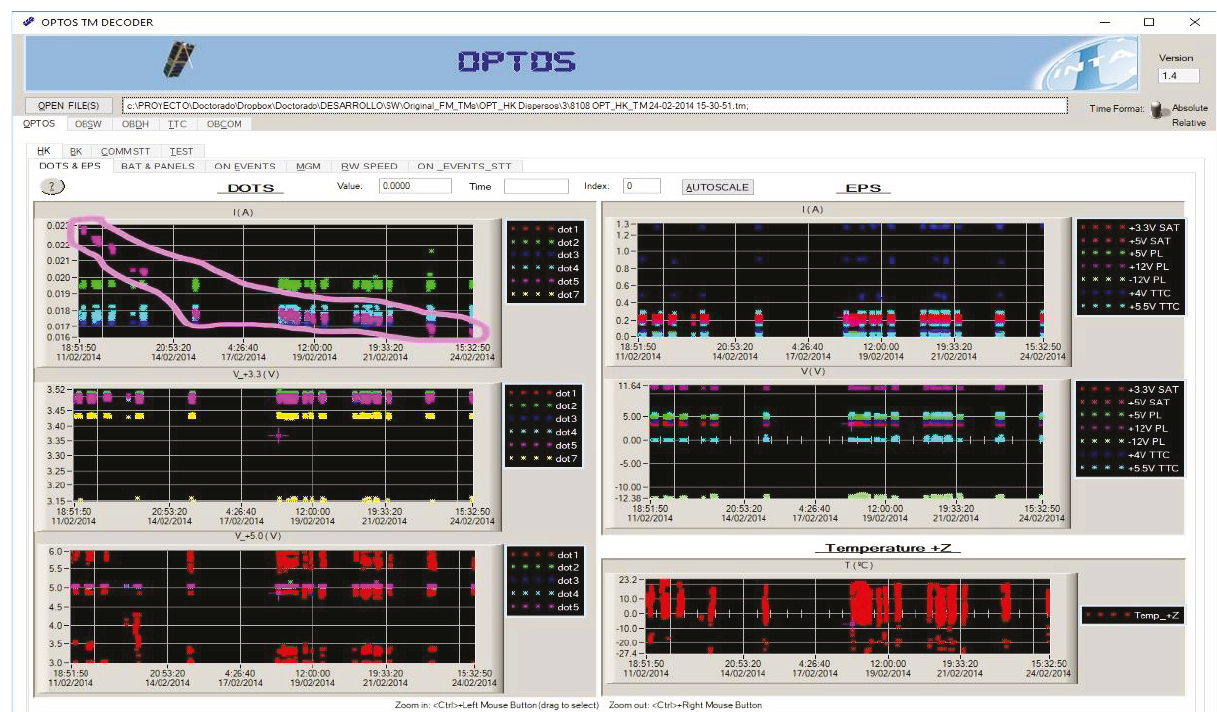
Figure 5: Housekeeping analysis of DOT 5 current deterioration